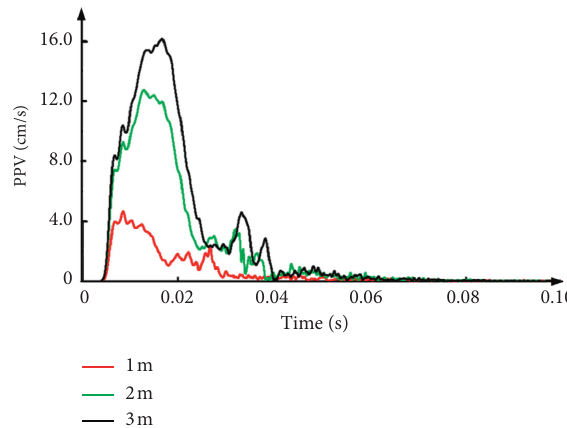
Figure 21: Changes of PPV of right wall with different explosive speed versus time.